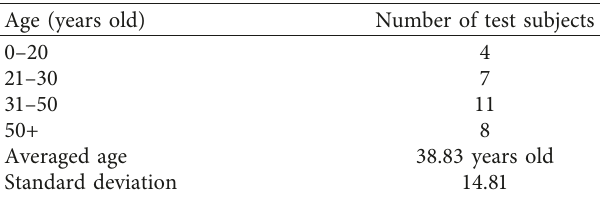
Figure 4: View from VR glasses: (a) the bedroom; (b) the rest area in a gym. Table 3: Age distribution of test